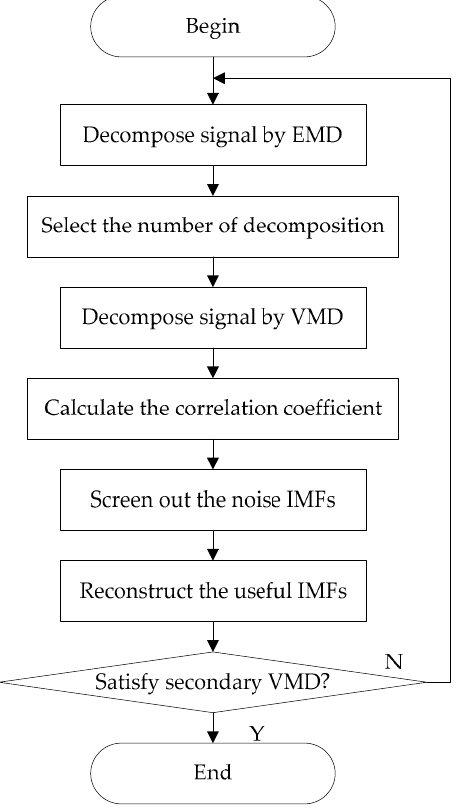
Figure 3. The flow chart of proposed secondary variational mode decomposition (2VMD) denoising algorithm.